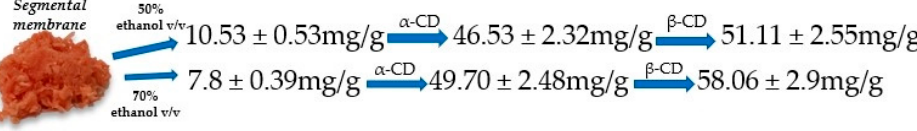
Figure 10. Naringin yield (control sample < α -CD < β -CD, respectively). Results are means ± SD ( n = 3). Table 4. Flavanone concentrations retrieved from samples using CDs.